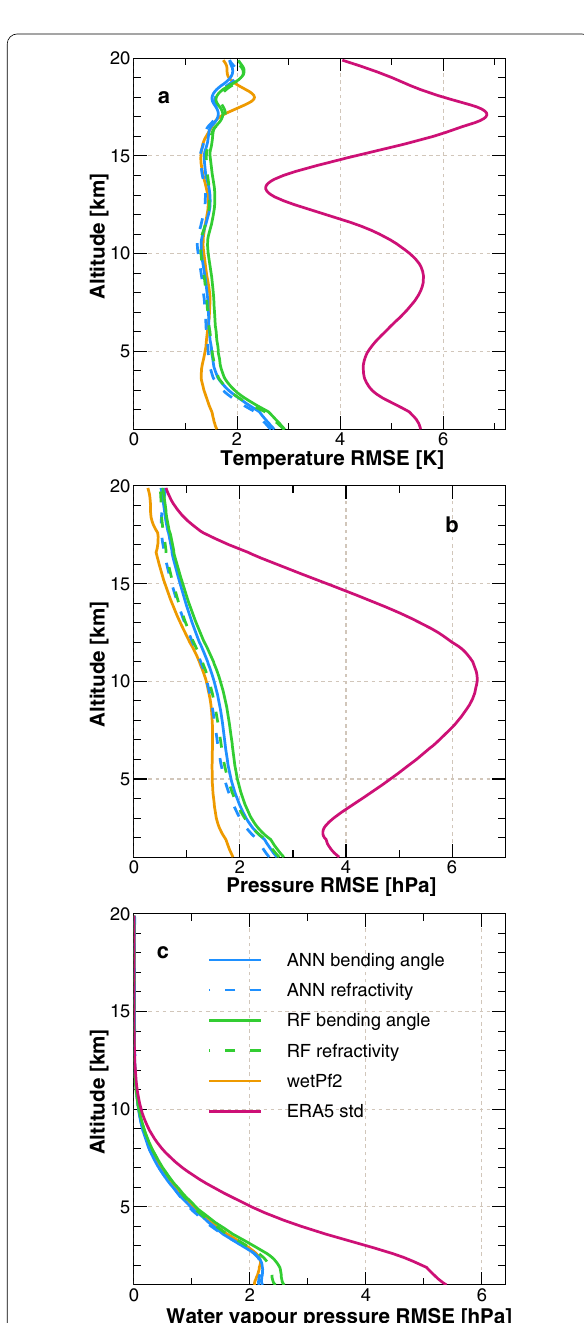
Fig. 3 Temperature ( a ), pressure ( b ) and water vapor partial pressure ( c ) RMSE vertical profiles. The errors are obtained on the testing data set from the operational 1DVar CDAAC wetPf2 product (orange lines), ANN (blue lines) and RF (green lines) approaches with bending angle (solid lines) or refractivity (dashed lines) inputs, with respect to the ERA5 targets. The pink lines present the ERA5 standard deviations